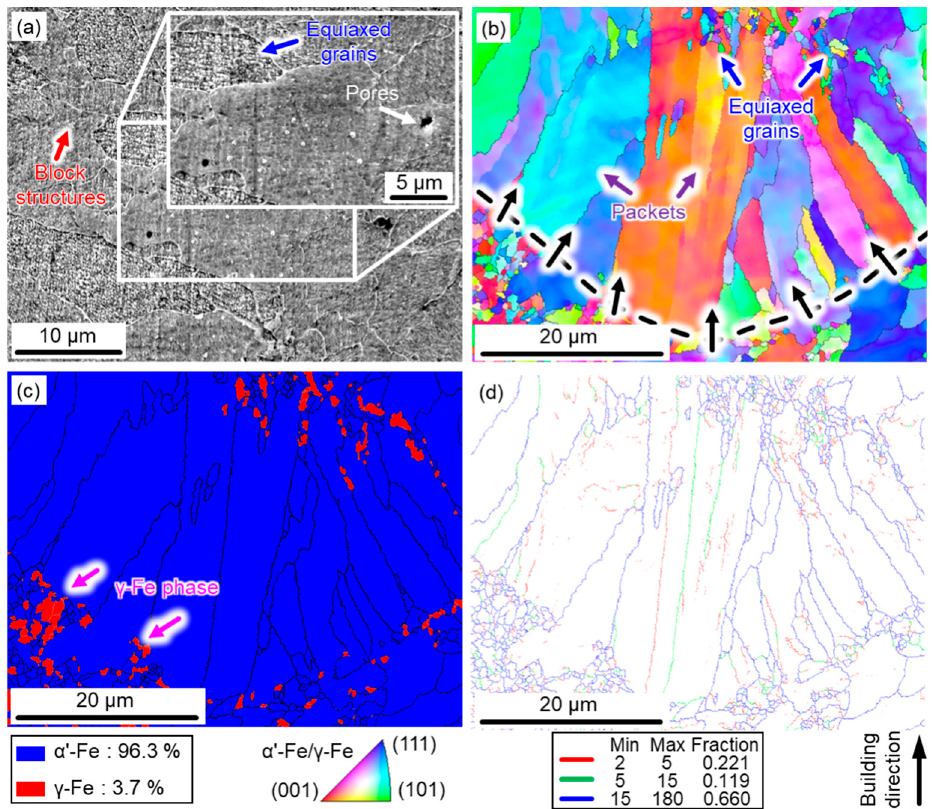
Figure 2. Microstructures of the SLM 17-4 PH steel under as-built conditions: ( a ) SEM; ( b ) IPF map; ( c ) phase distribution; ( d ) grain boundary map.